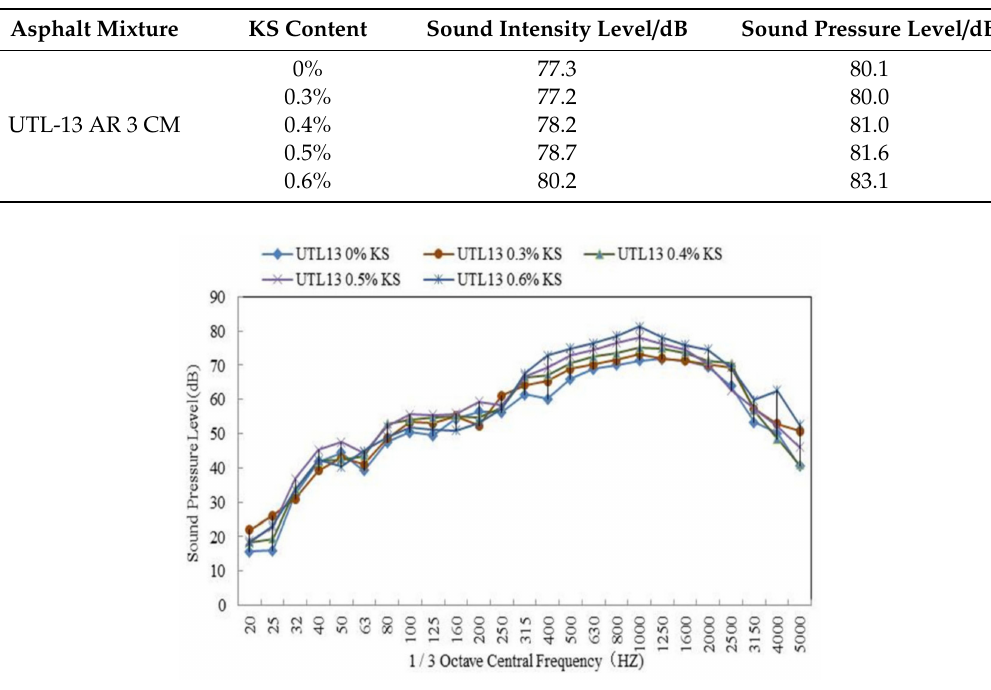
Figure 10. 1 / 3 octave band spectrum of UTL with di ff erent KS contents.